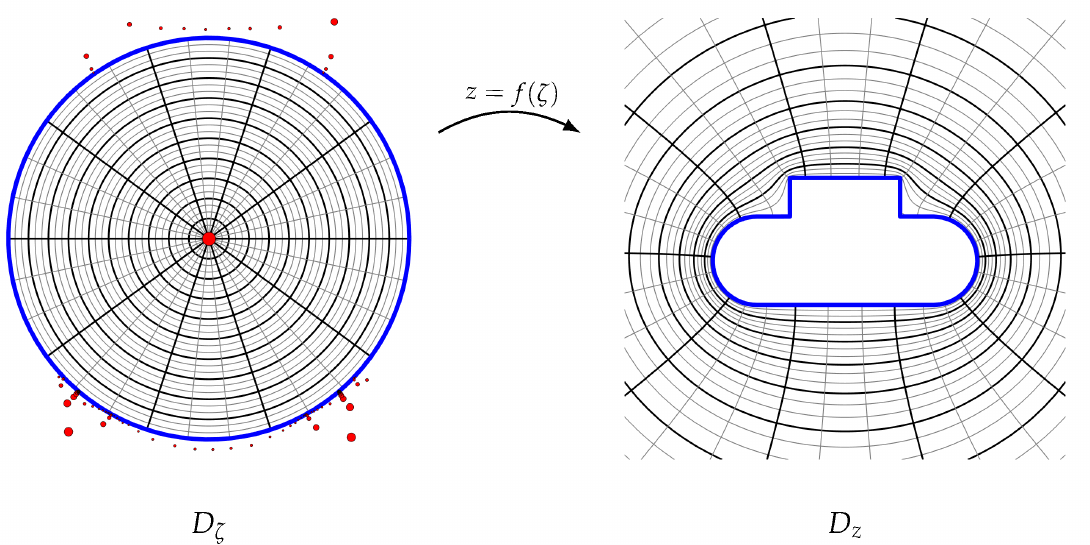
Figure 6. An example of a conformal map computed using the method of [60]. The red dots indicate the poles of the map and their size is proportional to their